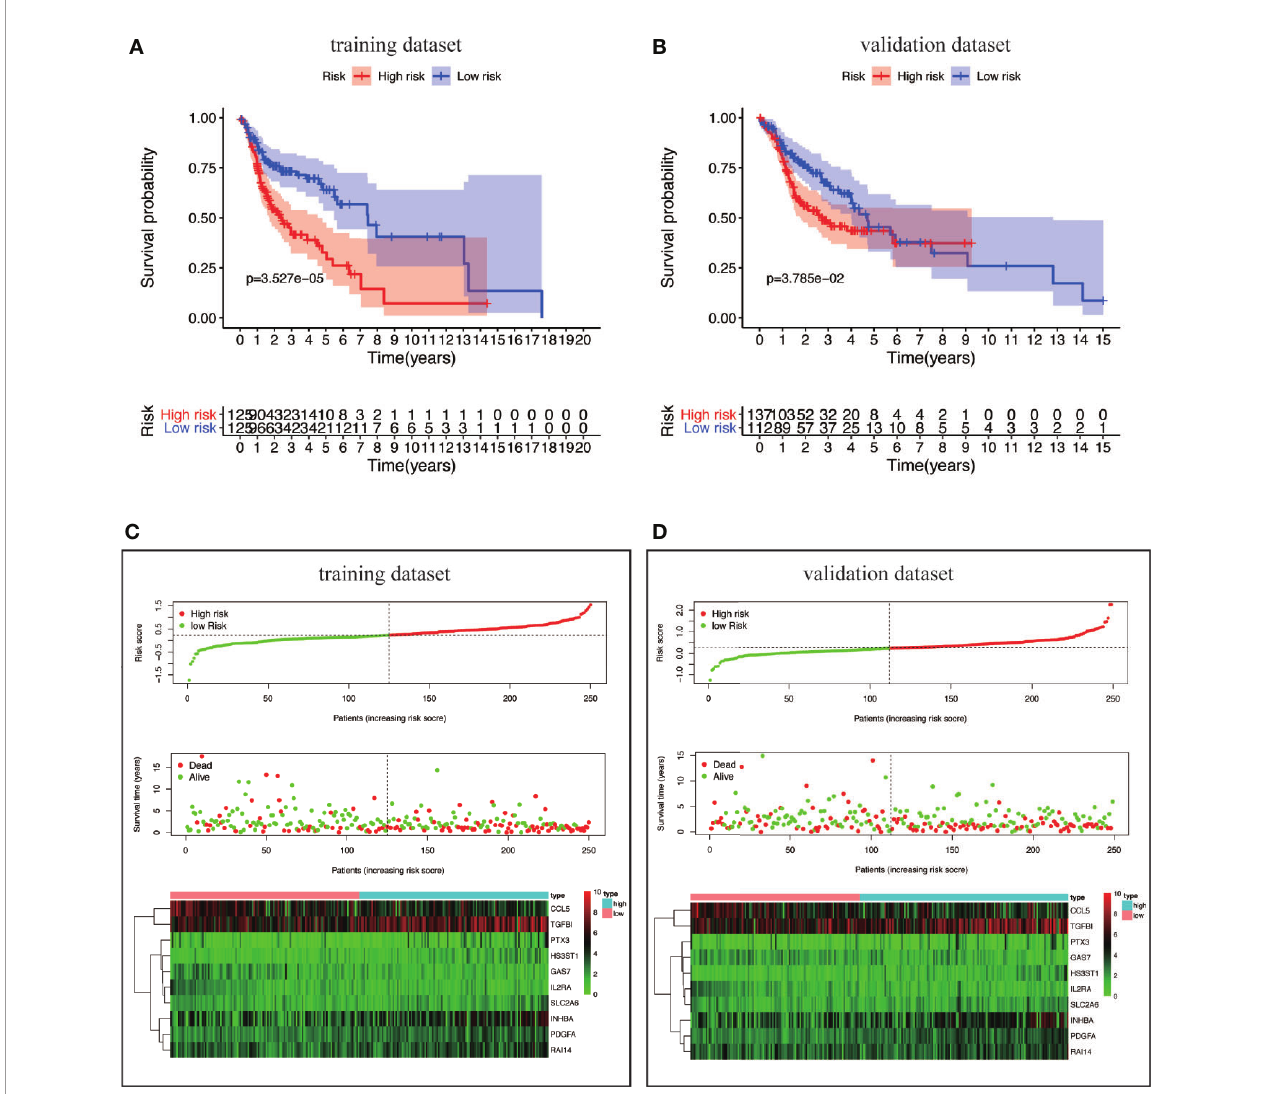
FIGURE 6 | Survival analysis and characteristics of the TBGs. (A, B) Kaplan – Meier survival curves of overall survival between the high-risk group and low-risk group in the training dataset and validation dataset. (C, D) The distribution of risk score, patient ’ s survival time and status, as well as TBGs expression pro fi les for the training dataset and validation